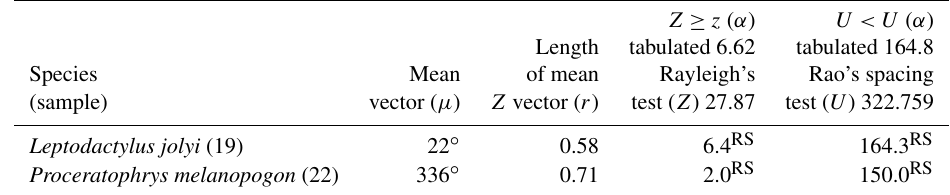
Table 2. Species with sufficient sample size and characterization of random behavior in the synodic cycle; n − 1 degrees of freedom and p = 0 . 01. RS = random sample.